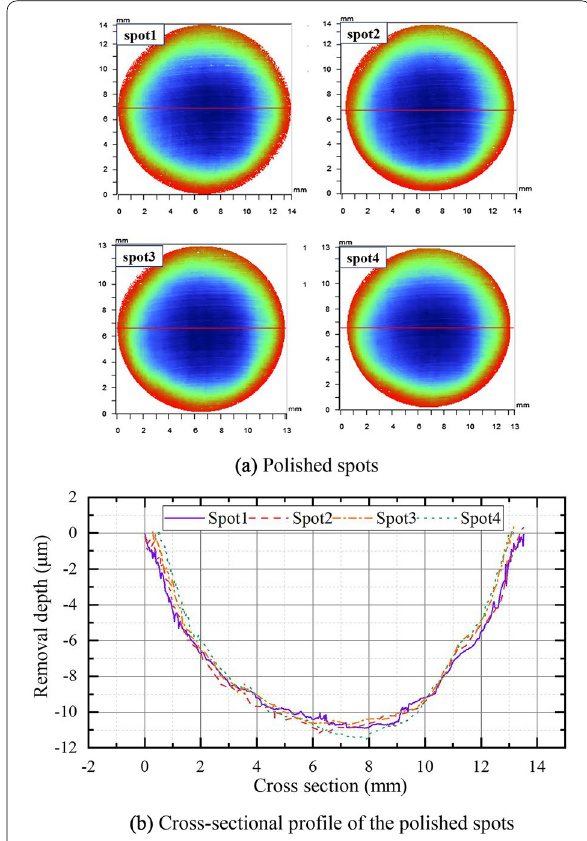
Figure 10 Results of spot polishing